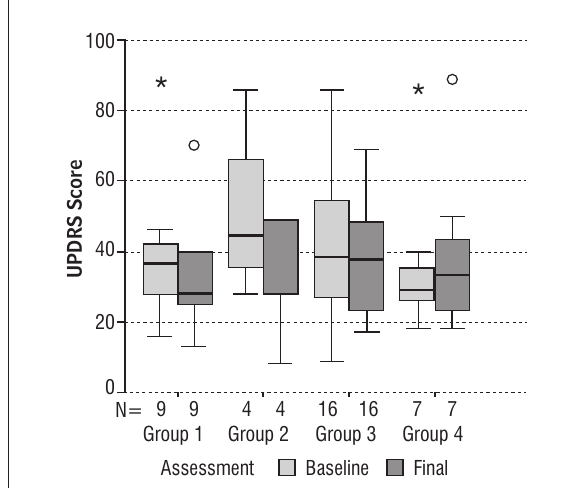
Figure 1 - UPDRS scores in the four groups Source: Research